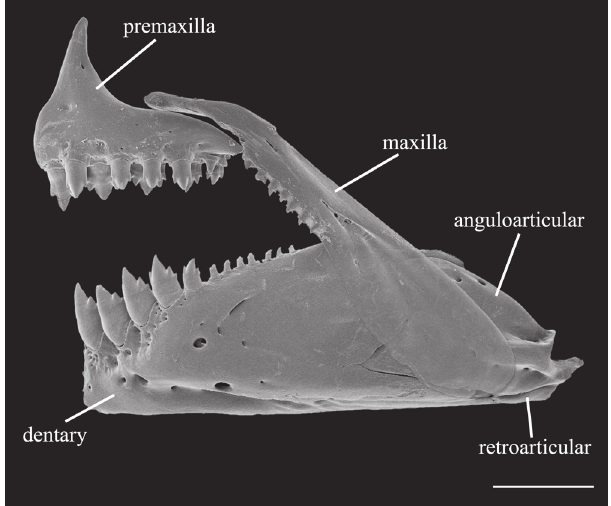
Fig. 3. Upper and lower jaws of Astyanax multidens